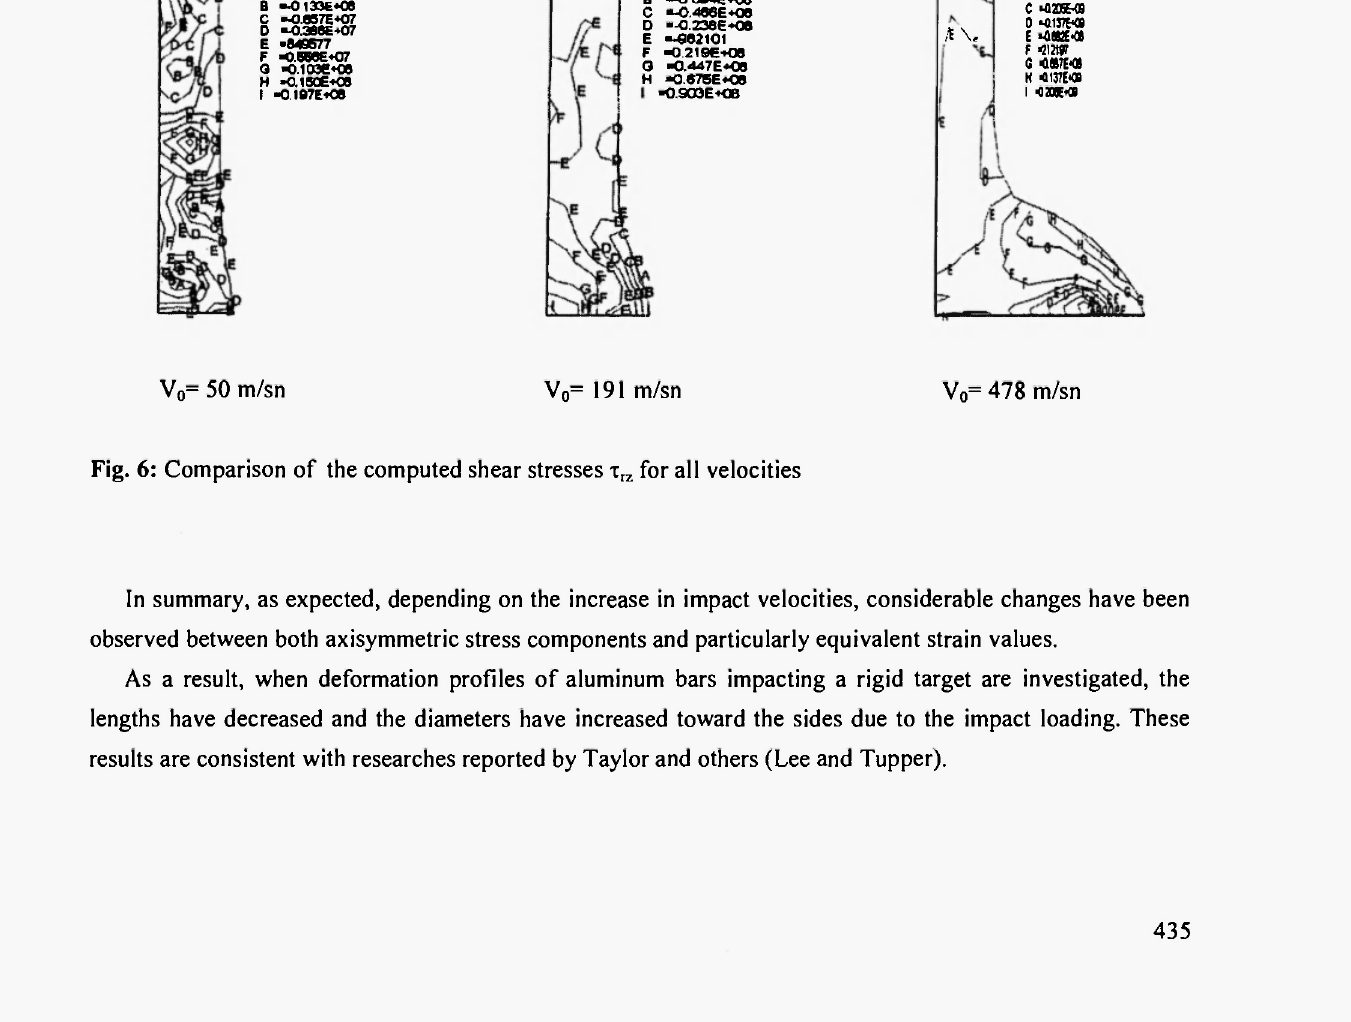
Fig. 5: Comparison of the computed tangential stresses σ θ for all velocities